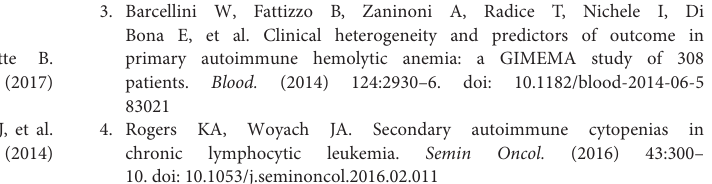
Supplementary Table 2 | Overview of sequencing results. Supplementary Table 3 | Shared CDR3 amino acid sequences. Supplementary Table 4 | Exclusive TRB clusters of healthy